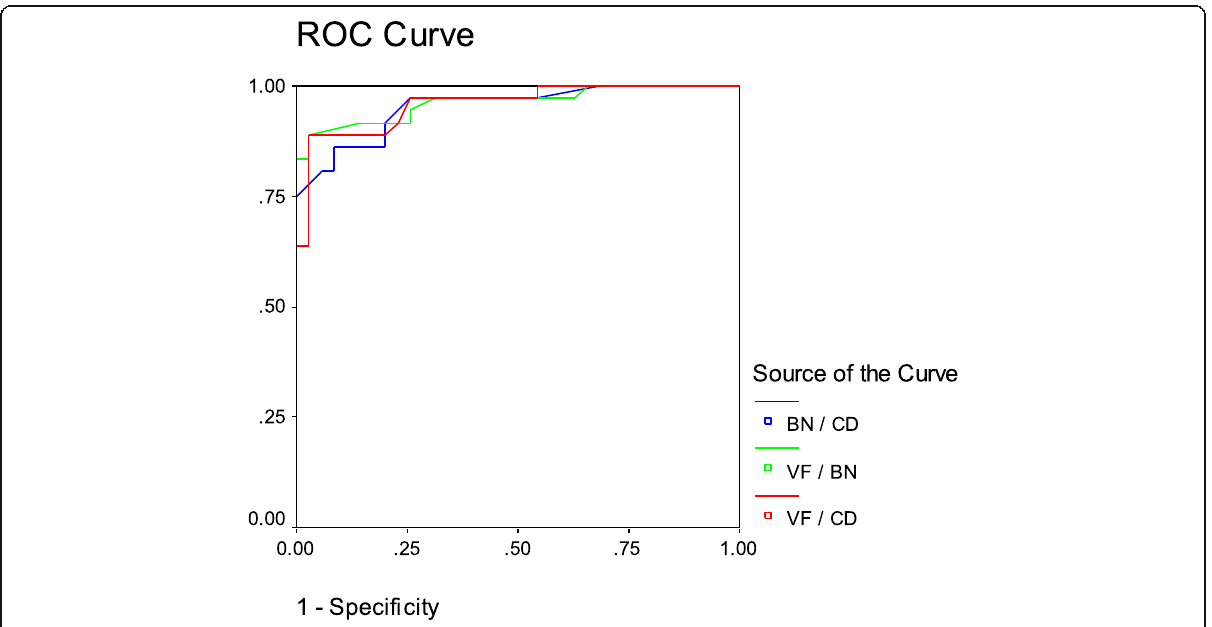
Fig. 1 ROC for different neurocognitive test combinations in illiterates